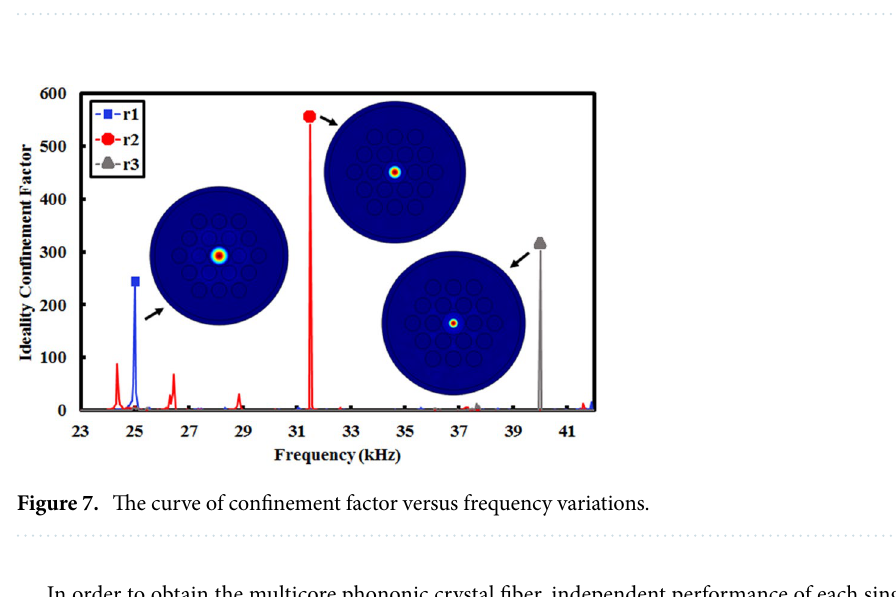
Figure 6. Cross-section of proposed multicore phononic crystal fiber with three different cores.